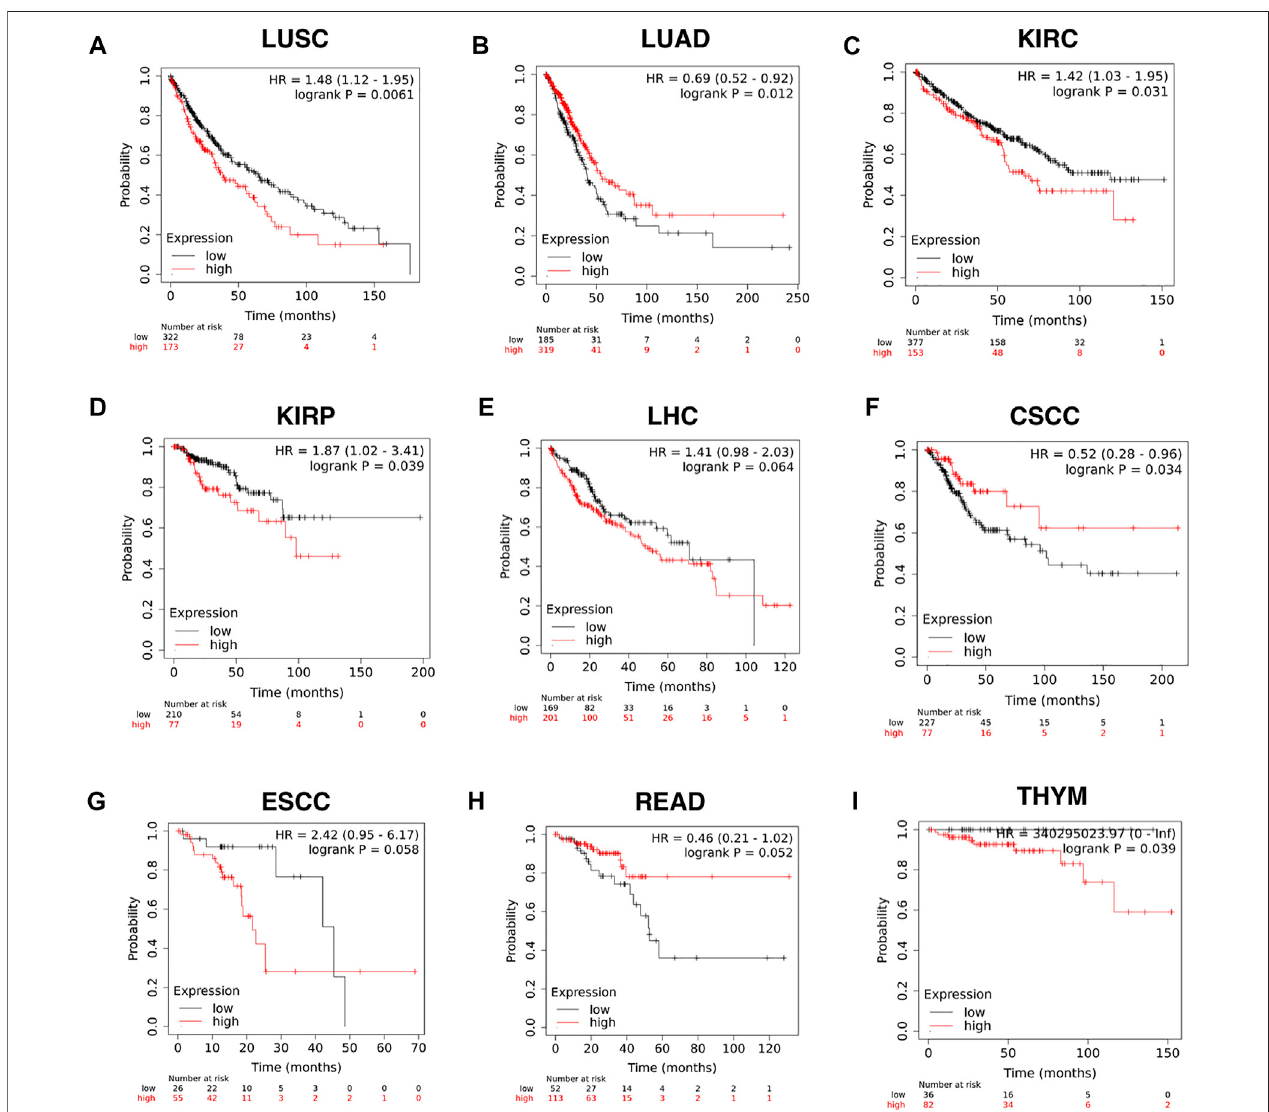
FIGURE 3 | Ef fi ciency of CD209 expression in the survival of speci fi c cancer patients analyzed with the Kaplan – Meier plotter. (A – I) Kaplan – Meier plotter of (A) LUSC, (B) LUAD, (C) KIRC, (D) KIRP, (E) LHC, (F) CSCC, (G) ESCC, (H) READ, and (I) THYM based on the expression level of CD209. Abbreviation: LUSC, lung squamous cell carcinoma; LUAD, lung adenocarcinoma; KIRC, kidney renal clear cell carcinoma; KIRP, kidney renal papillary cell carcinoma; CSCC, cervical squamous cell carcinoma; LHC, liver hepatocellular carcinoma; ESCC, esophageal squamous cell carcinoma; READ, rectum adenocarcinoma; THYM, thymoma.